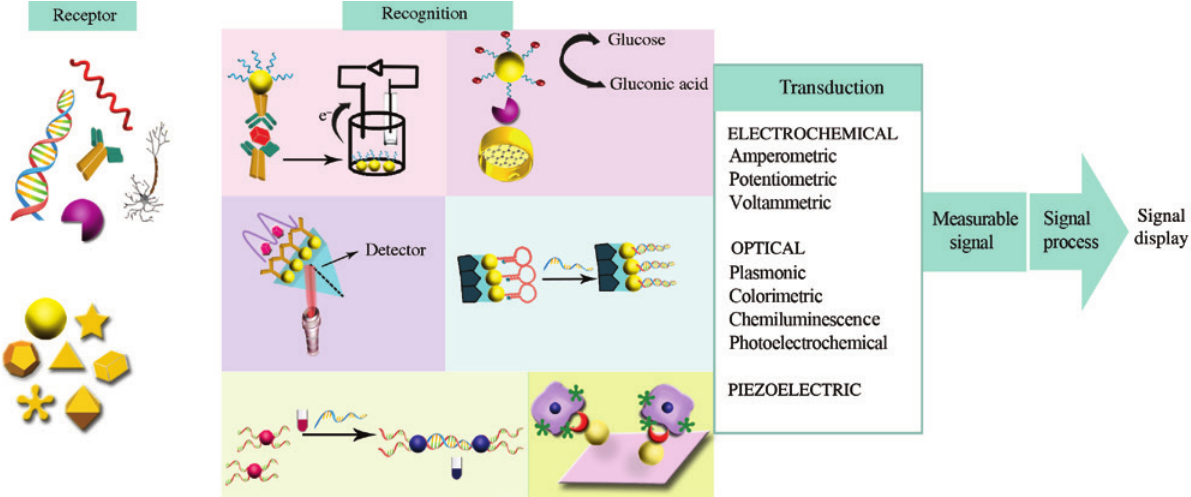
Figure 1: The role of noble MNPs in various types of